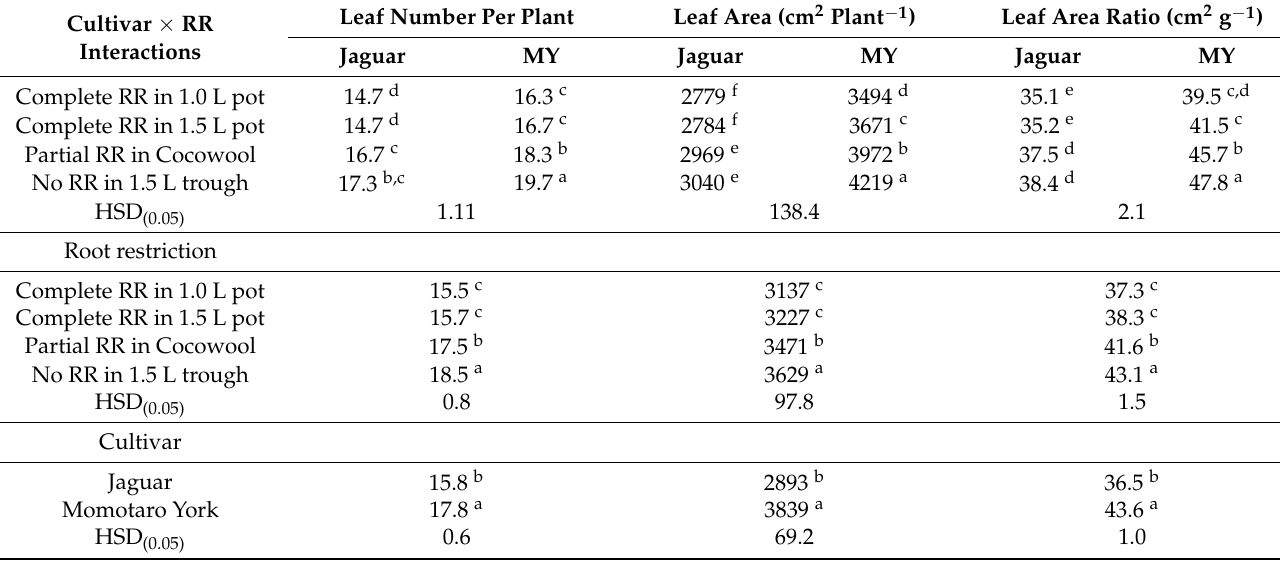
Table 1. Effect of root restriction (RR) on plant growth parameters of tomato cultivars at 8 weeks after transplanting (WAT). Cultivar × RR